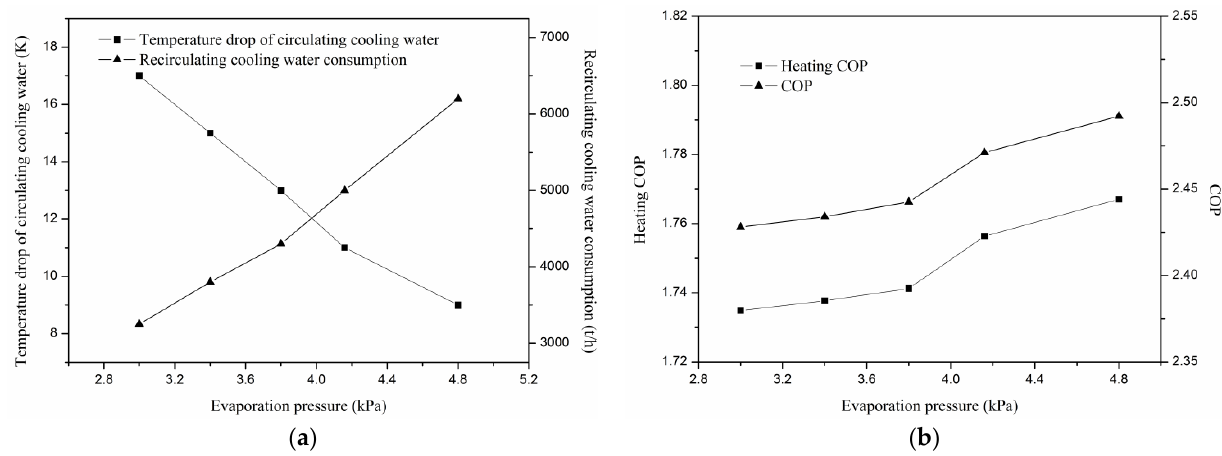
Figure 2. Effect of evaporator pressure on different parameters: ( a ) temperature drop and consumption of circulating cooling water; ( b ) heating COP and total COP.